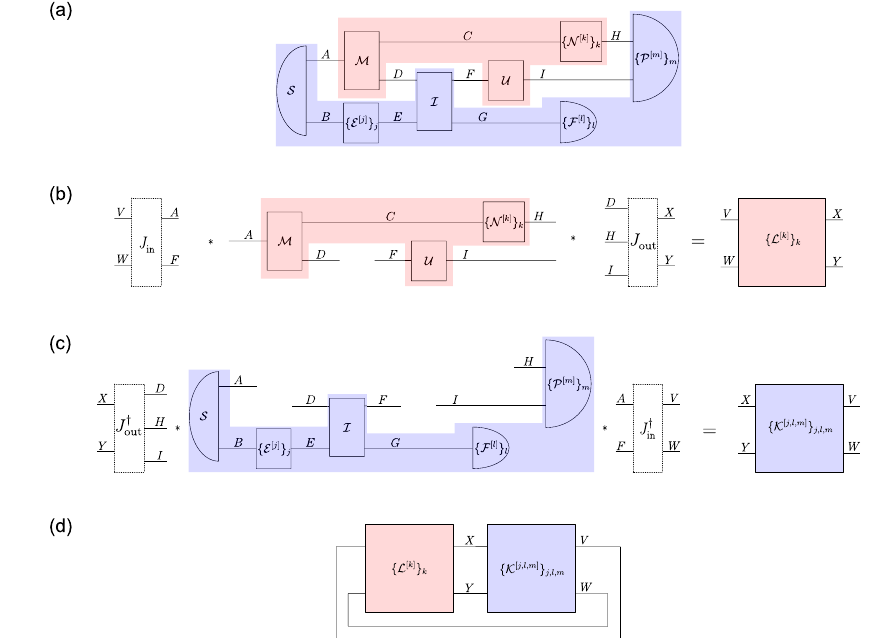
Fig. 2 | Description of a quantum circuit in terms of time-delocalised sub- systems. a Example of a quantum circuit, consisting of quantum operations S , M , f E ½ j (cid:3) g j , I , U , f N ½ k (cid:3) g k , f F ½ l (cid:3) g l , f P ½ m (cid:3) g m , which are composed through the systems A , B , C , D , E , F , G , H , I , and a decomposition thereof into fragments, corresponding totheredandblueboxes.Theredfragmentimplementsitselfaquantumoperation from the incoming systems A and F to the outgoing systems D , H and I , which are each associated with different times. It iscomposed with its complement, the blue fragment, which implements a quantum operation from the systems D , H , I to